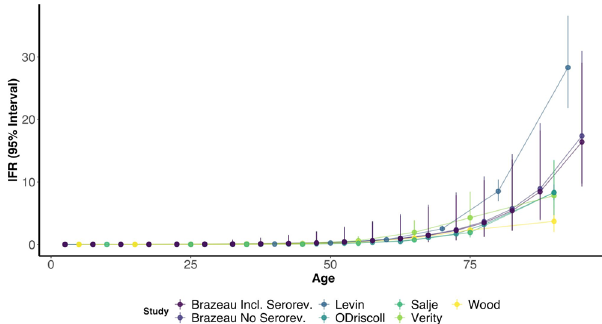
Fig. 8 Comparison of age-speci fi c COVID-19 IFR estimates during the fi rst-wave. We compare estimates from the current study (Brazeau; including seroversion (Incl. Serorev.) vs. excluding seroreversion